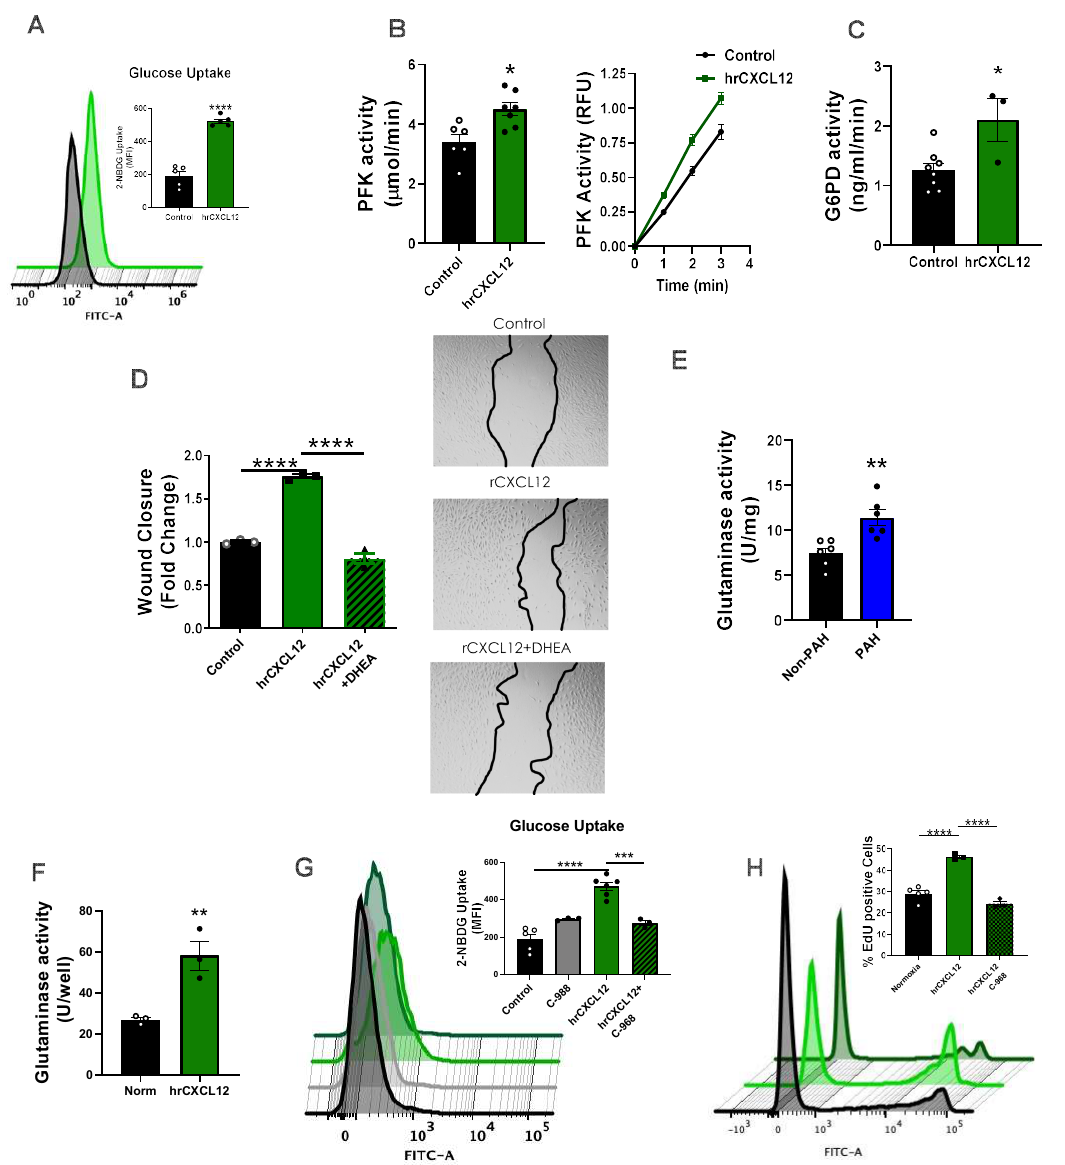
Figure 4. CXCL12 induces pro-proliferative metabolic activity . ( A ) hPAECs were treated with recombinant CXCL12 for 24 h and glucose uptake was analyzed by fluorescent NBGD using flow cytometry. Representative flow cytometry histograms depict mean fluorescent intensity of FITC along the x axis, with a rightward shift of the peak indicating increased glucose uptake. ( B ) Phos- phofructokinase (with RFU/min kinetic activity, inset) and ( C ) glucose-6-phosphate dehydrogenase (G6PD) activity were tested in hPAECs treated with hrCXCL12 vs. control. ( D ) Wound closure was measured in hPAECs treated with hrCXCL12 along with the glucose-6-phosphate dehydrogenase inhibitor DHEA or vehicle (methanol); inset shows images at 24 h. ( E ) Lung lysates from age- and sex-matched PAH and non-PAH subjects were assessed for glutaminase activity (n = 6). ( F ) hPAECs treated with hrCXCL12 were assessed for glutaminase activity after 24 h stimulation. ( G , H ) hPAECs treated with hrCXCL12 plus or minus the glutaminase inhibitor C-968 or vehicle (DMSO) to measure ( G ). glucose uptake (fluorescent NBGD-flow cytometry) and ( H ). proliferation (Click-it Edu-flow cytometry). Representative flow cytometry histograms in H depict populations of EdU-positive and -negative cells in a sample along the x axis, with a righthand peak cluster indicating proliferating cells taken as percentage to the total number of cells in the sample (for gating see Figure S1F). Results were analyzed with Student t-test ( A – C , E , F ) and one-way ANOVA and Holm–Sidak post hoc analysis ( D , G , H ) * p < 0.05, ** p < 0.01, *** p < 0.001, **** p <